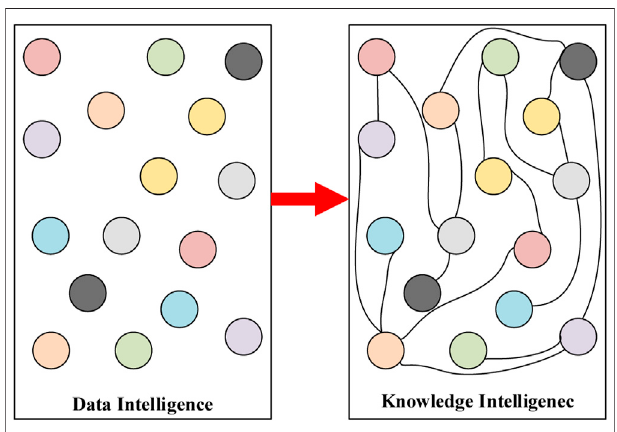
FIGURE 1 | Impact of the knowledge graph on the age of arti fi cial